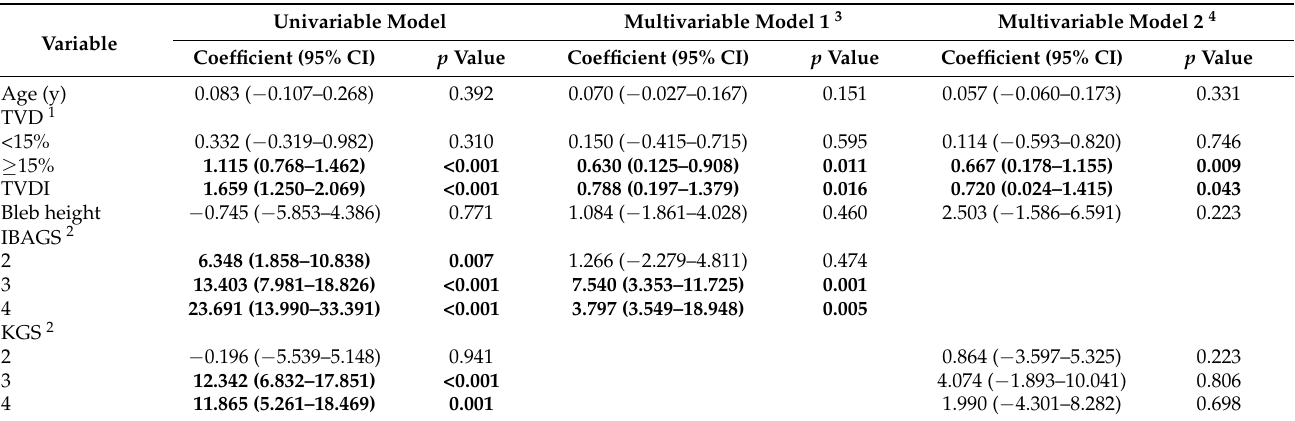
Table 4. Univariate and multivariate linear regression analysis for